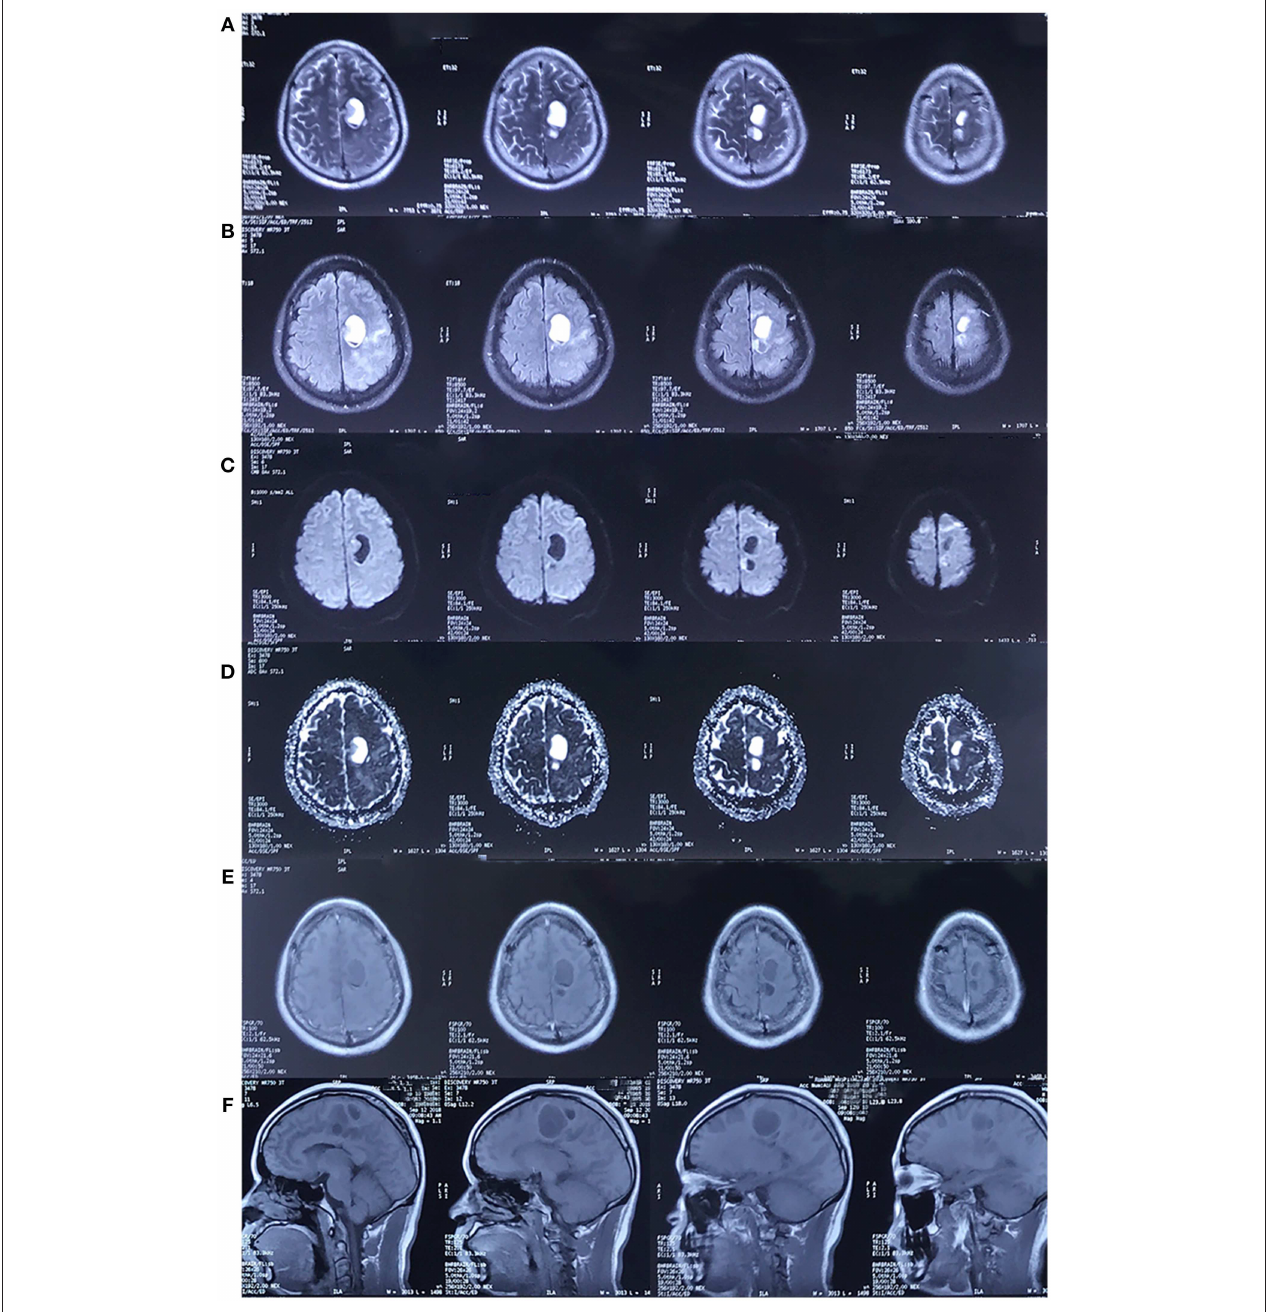
FIGURE 4 | MRI in September 2018. The cystic lesion in left frontal lobe was enlarged. The lesion showed the same characteristics as the MRI scan performed in 2017. [ (A–F) Represents T2-weighted image, FLAIR, DWI, ADC, axial and sagittal post-contrast T1-weighted image, respectively. The pre-contrast T1-weighted image was